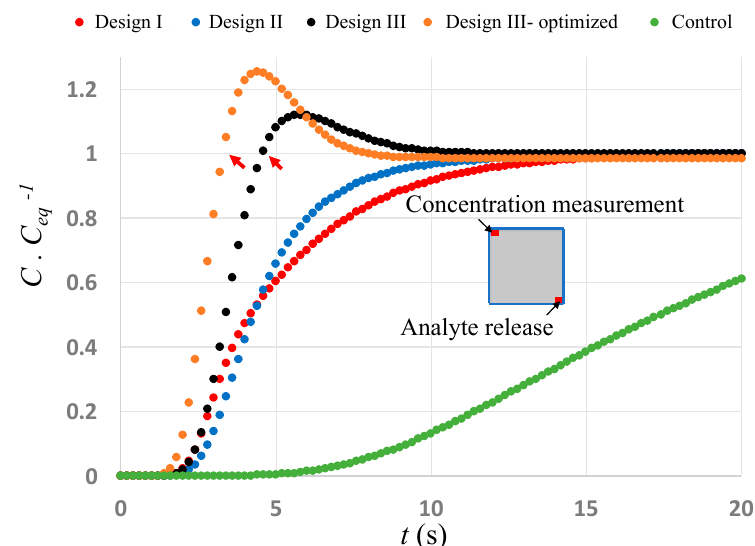
Figure 4. Average changes of concentration ratio inside a 20 × 20 µ m region located diagonally across from the initial analyte release region. The inset image shows the location of analyte release and analyte measurement on the channel cross-section. C eq represents equilibrium concentration. The fastest increase in concentration is for the optimized Design III (orange line), where a higher than equilibrium concentration is achieved in less than 3.4 s. Since convective fluxes are critical in analyte transport, the mixing in all of the designs is significantly higher than a diffusion-only mixing strategy (green line), where, as in most microfluidic applications, the fluid is not actively mixed transversally while passing through a microfluidic channel. The diffusion-only control curve (green) reaches equilibrium ( C · C − 1 eq = 1 ) at t = ~ 70 s (not shown).